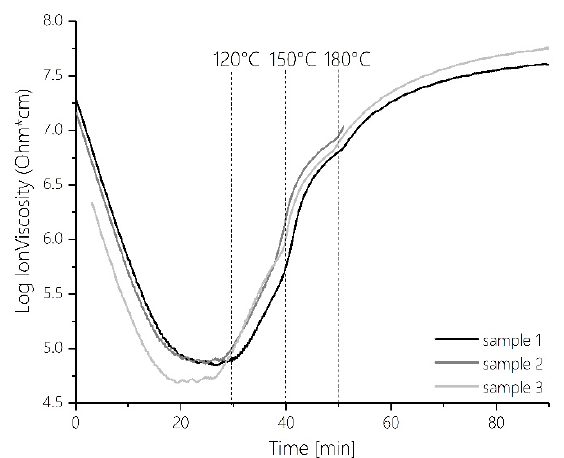
Figure 7. Time-dependent profile of ion viscosity during MF resin cure as measured by dielectric Figure7. analysis .